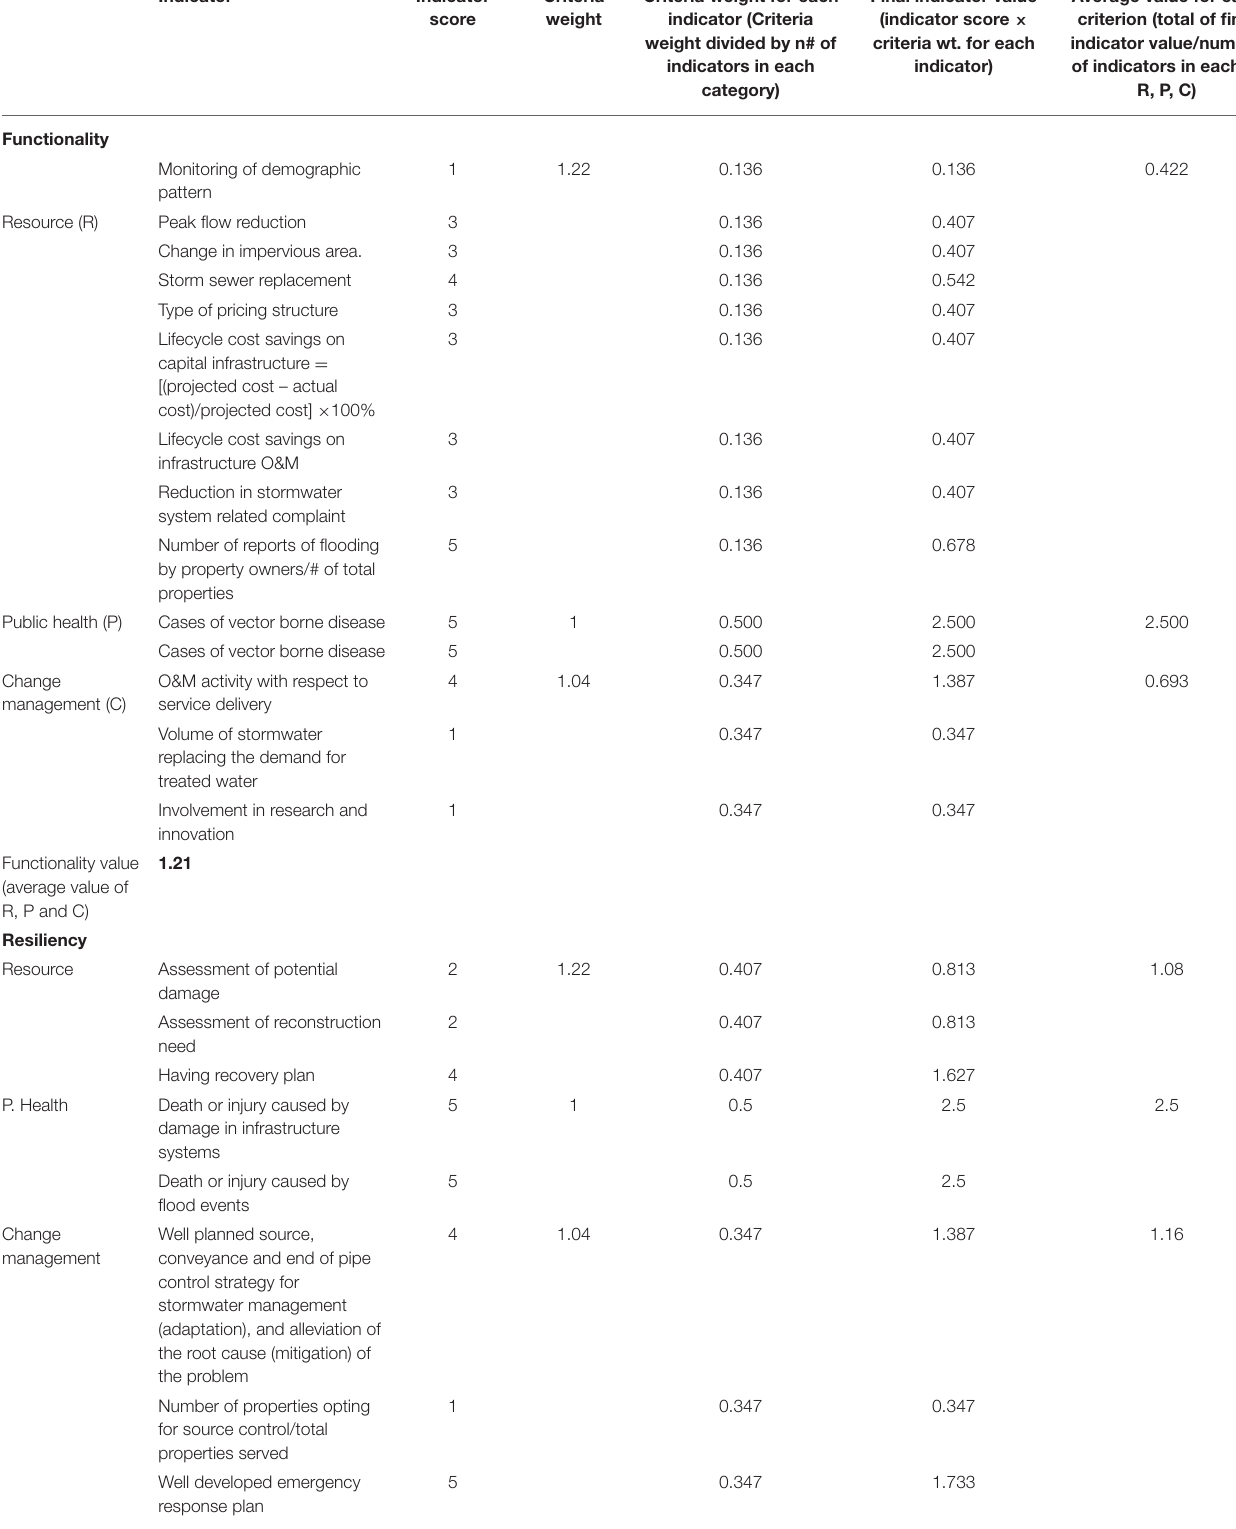
TABLE 3 | FRS assessment of the South Windsor Stormwater System. Indicator Indicator